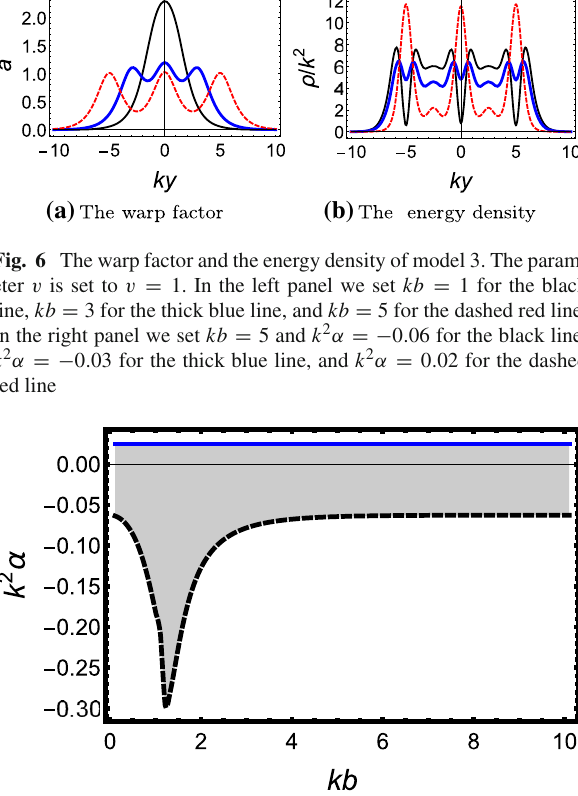
Fig. 7 Plotoftherange(thedarkregion)of k 2 α and kb inthecondition of f R > 0 for model